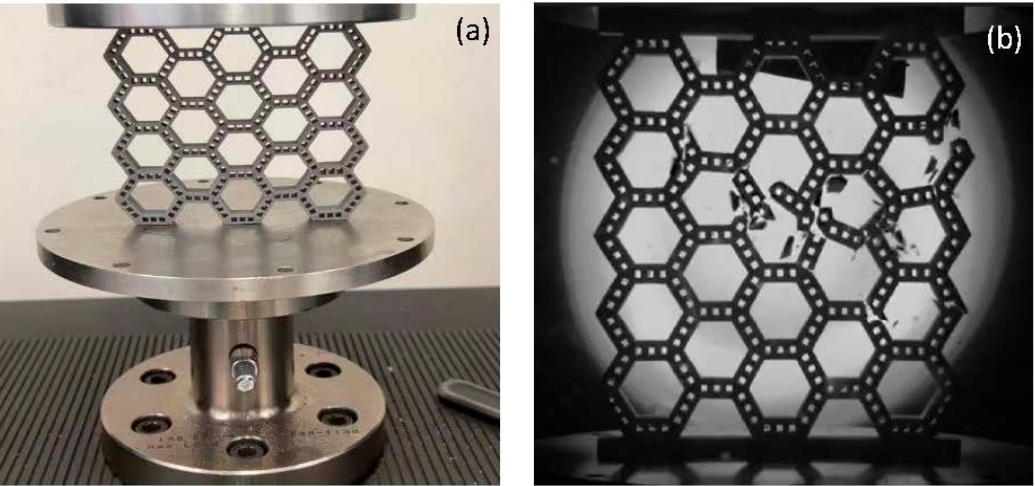
Figure 2. ( a ) A 4 × 4 unit cell test structure affixed between the rigid plates of the Instron machine and ( b ) fracture of a 5 × 5 unit cell test structure under transversal compressive loading captured by a high-speed camera.